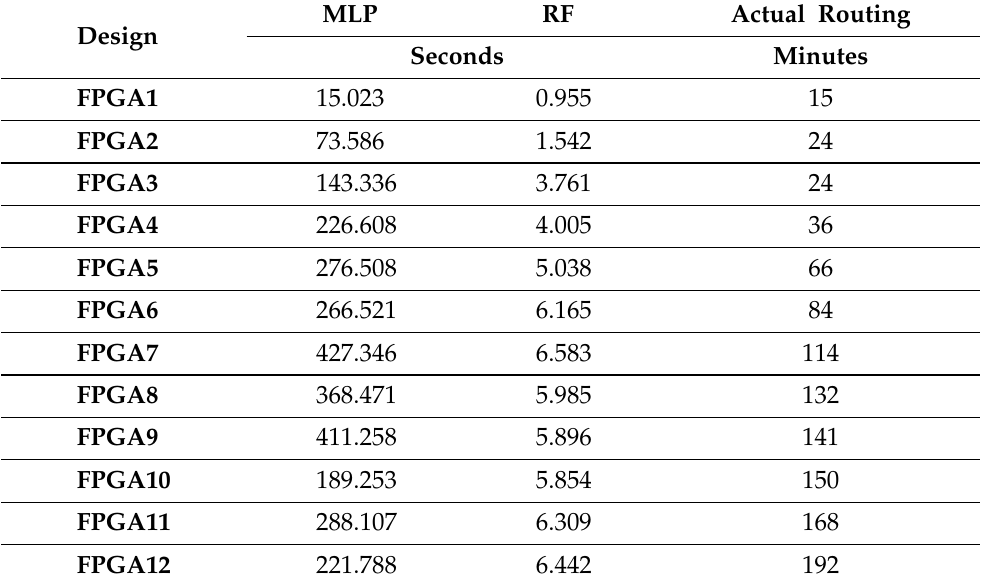
Table 6. Prediction time using ML model vs. Actual Xilinx Vivado 2018.3 Routing